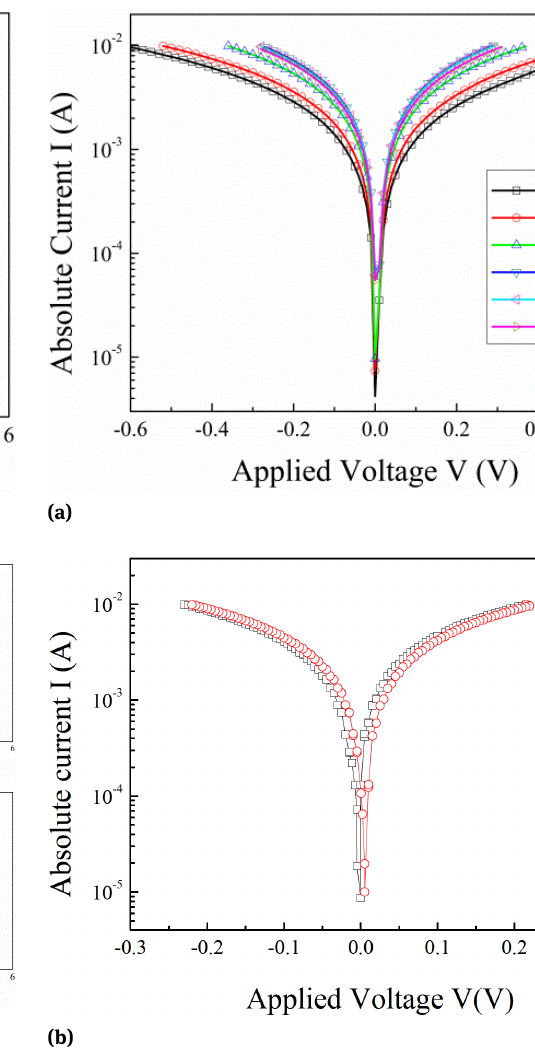
Figure 4: I-V characteristics of the PANi/PVA/10 wt% Fe 3 O 4 blend nanocomposites a) at different temperatures b) cyclic run at 70 ∘